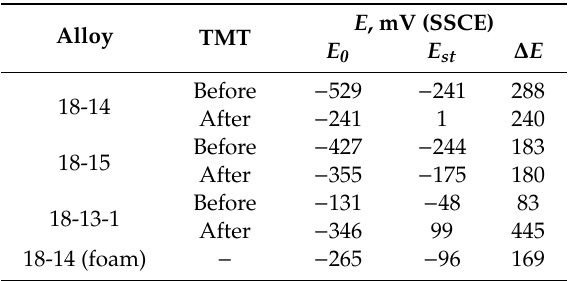
Table 6. OCP curve features for the 18-14, 18-15, and 18-13-1 alloys before and after TMT, and the 18-14-based foam material in Hanks’ solution at 310 K. 18-14-based foam material in Hanks’ solution at 310 K.